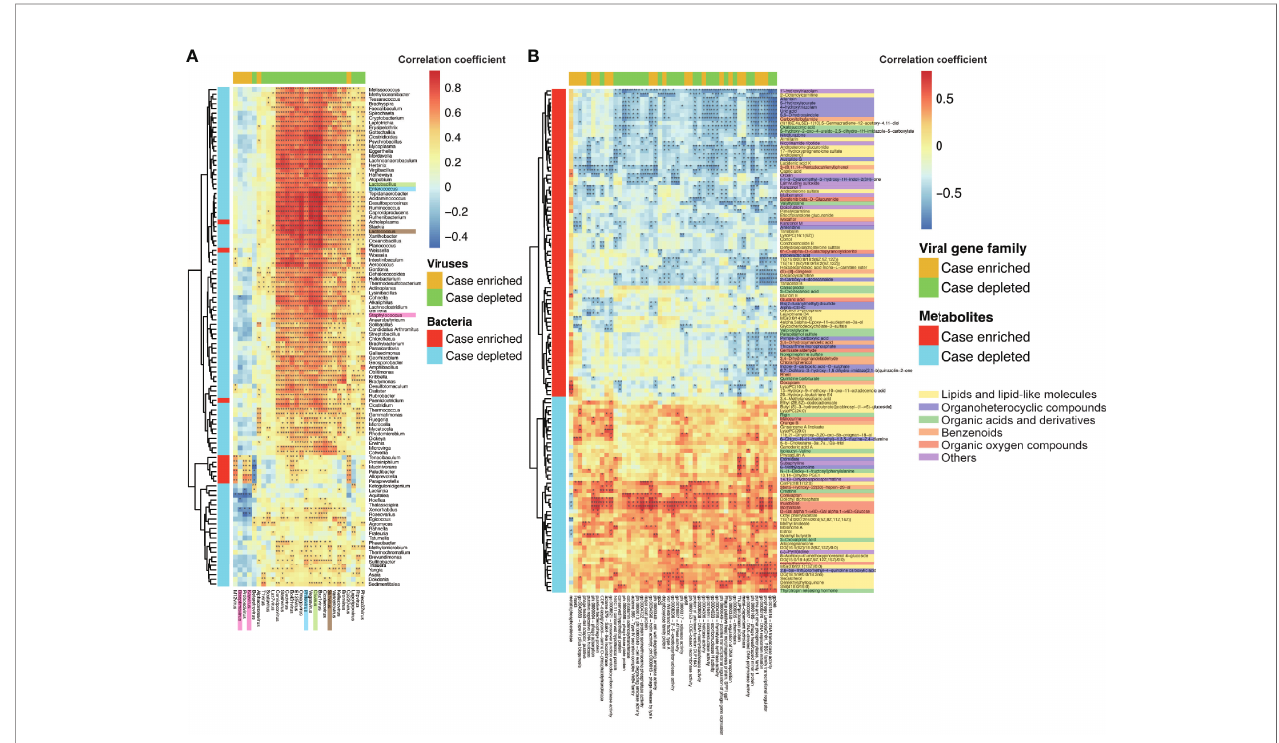
FIGURE 2 | Correlations among viruses, bacteria, and metabolites. (A) Heatmap of the Spearman correlations between signi fi cantly different viruses (column) and signi fi cantly different bacteria (row). There were 22 viruses in genus level depleted and six enriched in the IBS group (Mann – Whitney U test, p ≤ 0.05), 97 bacteria in genus level depleted, and nine enriched in the IBS group (Mann – Whitney U test, p ≤ 0.05). The signi fi cances of correlations were labeled with “ * ” (FDR p < 0.05) and “ ** ” (FDR p < 0.01). The same color-labeled names of bacteria or viruses indicate the pairs of infective phages and their bacteria hosts. (B) Heatmap of the Spearman correlations between signi fi cantly different viral gene families (column) and signi fi cantly different metabolic ions (row). There were 51 metabolic ions depleted and 85 enriched in the IBS group ( t- test, p ≤ 0.05). The signi fi cances of correlations were labelled with “ * ” (FDR p < 0.05) and “ ** ” (FDR p <